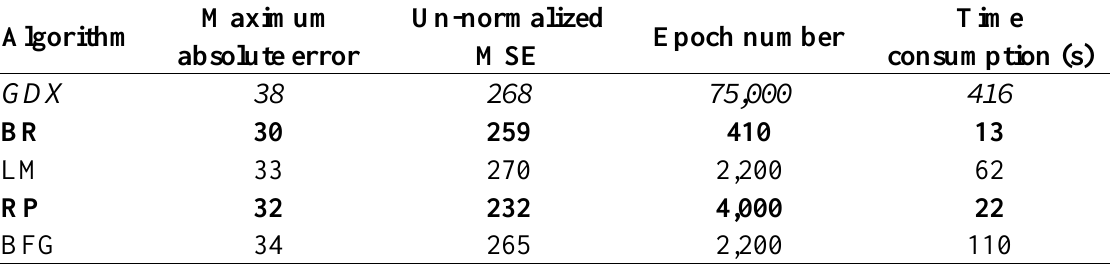
Table 3. Network structures of the proposed